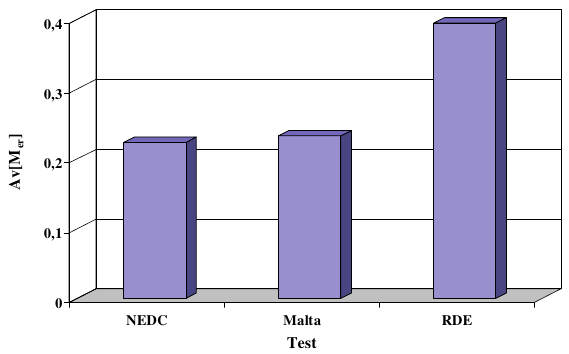
Fig. 7. A set of points in coordinates of engine rotational speed–relative torque in the NEDC test